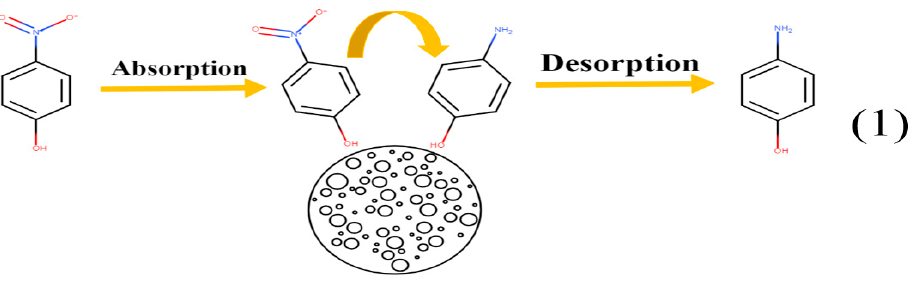
Figure 5. The electrode reaction mechanism of 4-NP on the CLR － PC/GCE.